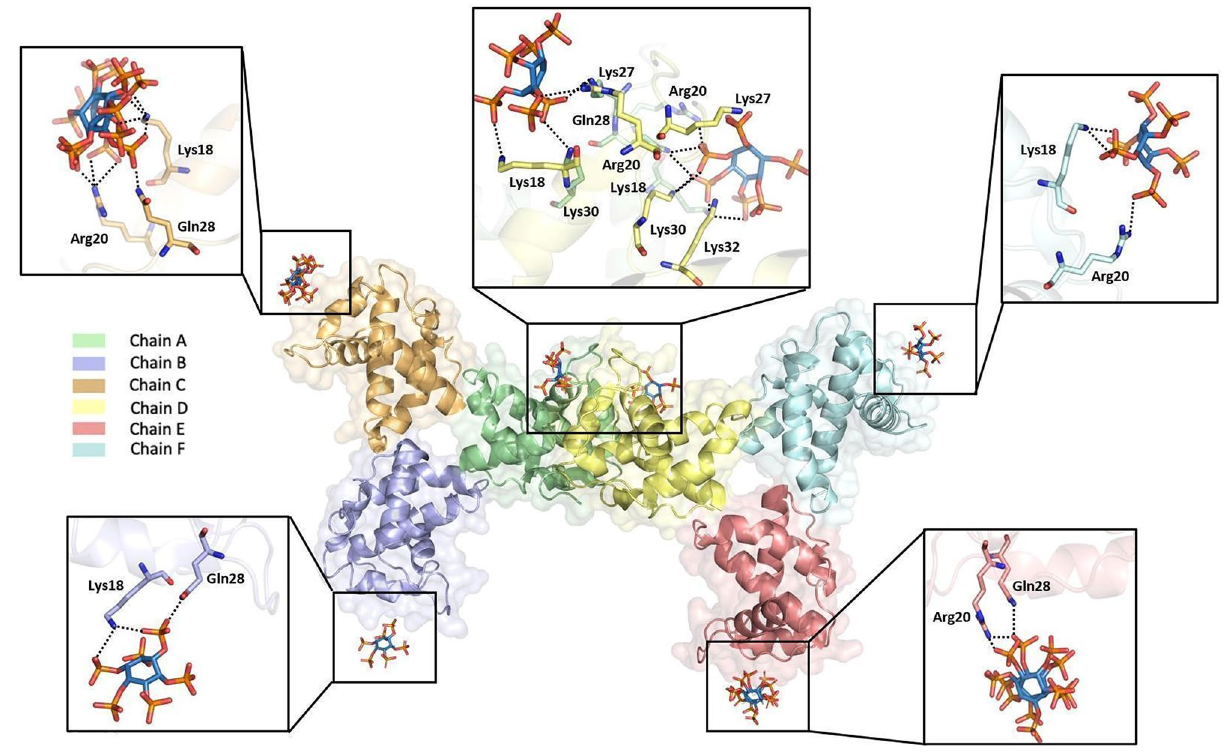
Figure 6. Representation of interactions on MA_IP6_C2 structure. The oligomeric structure of MA carries several IP6 molecules that interact with different residues between two trimeric proteins according to single trimer and IP6 interactions. Each chain is colored by individual colors as indicated previously. Carbon, oxygen and phosphorus atoms of IP6 are colored by sky-blue red and orange, respectively. The polar contacts between IP6 molecules and residues of MA oligomer are shown with dotted